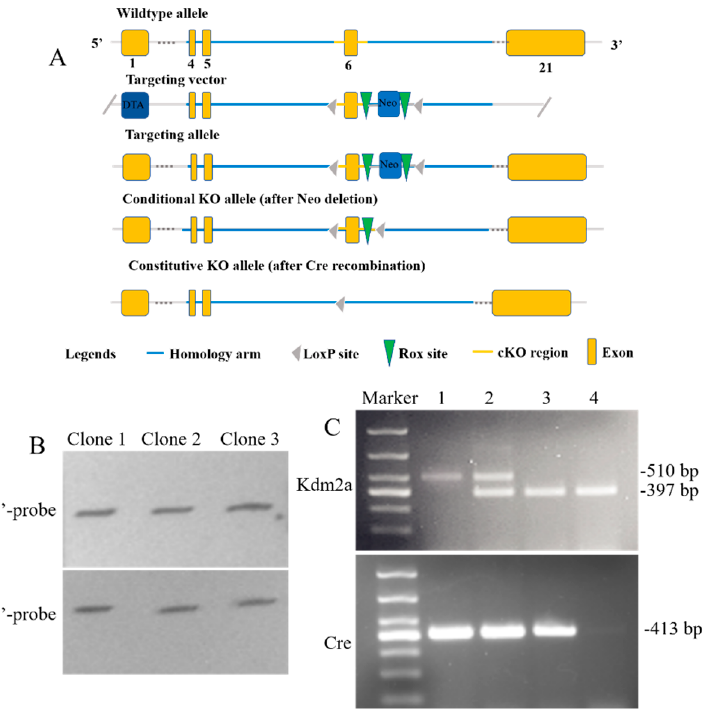
Figure 1. Generation of Kdm2a conditional knockout mice and confirmation. ( A ) The gene targeting strategy. The Kdm2a genomic locus, targeting vector, and targeted allele are sketched. ( B ) Southern blot analyses of Kdm2a floxed ESC lines with 5 ′ -probe and 3 ′ -probe. Representative results from three independent clones ( Kdm2a flox/flox ) were presented. The 5 ′ probe and the 3 ′ probe represent the targeted alleles as indicated. ( C ) Oocyte-specific deletion of the Kdm2a gene in genotyping of the litters was confirmed. M: DNA Marker, line 1: Kdm2a flox/flox ; Zp3 -Cre (cKO), line 2: Kdm2a flox/wt ; Zp3 -Cre, line 3: Kdm2a wt/wt ; Zp3 -Cre, line 4: Kdm2a wt/wt